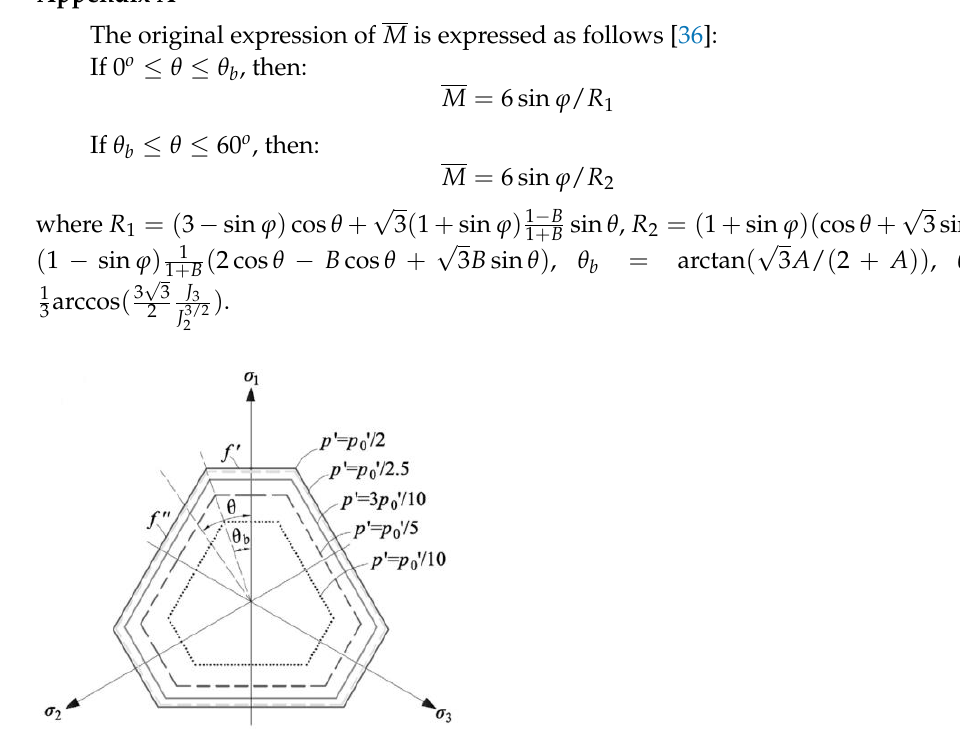
Figure A1. Bounding surface on the deviatoric plane (from reference [36]).